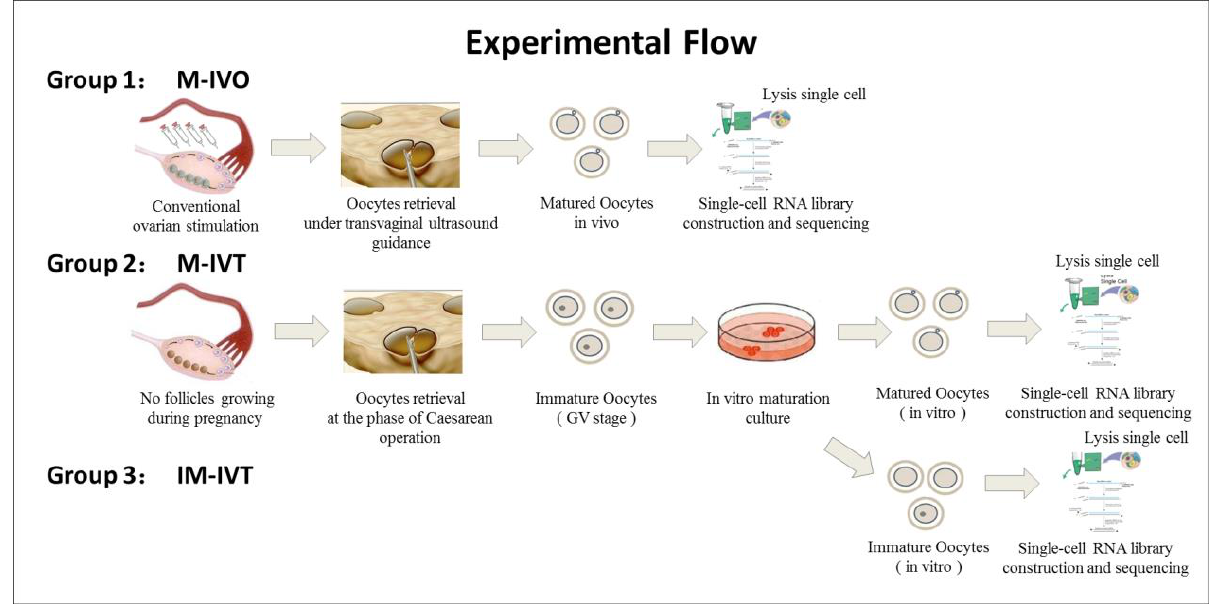
Figure 1. Schematic representation of the experimental procedures and group treatments.